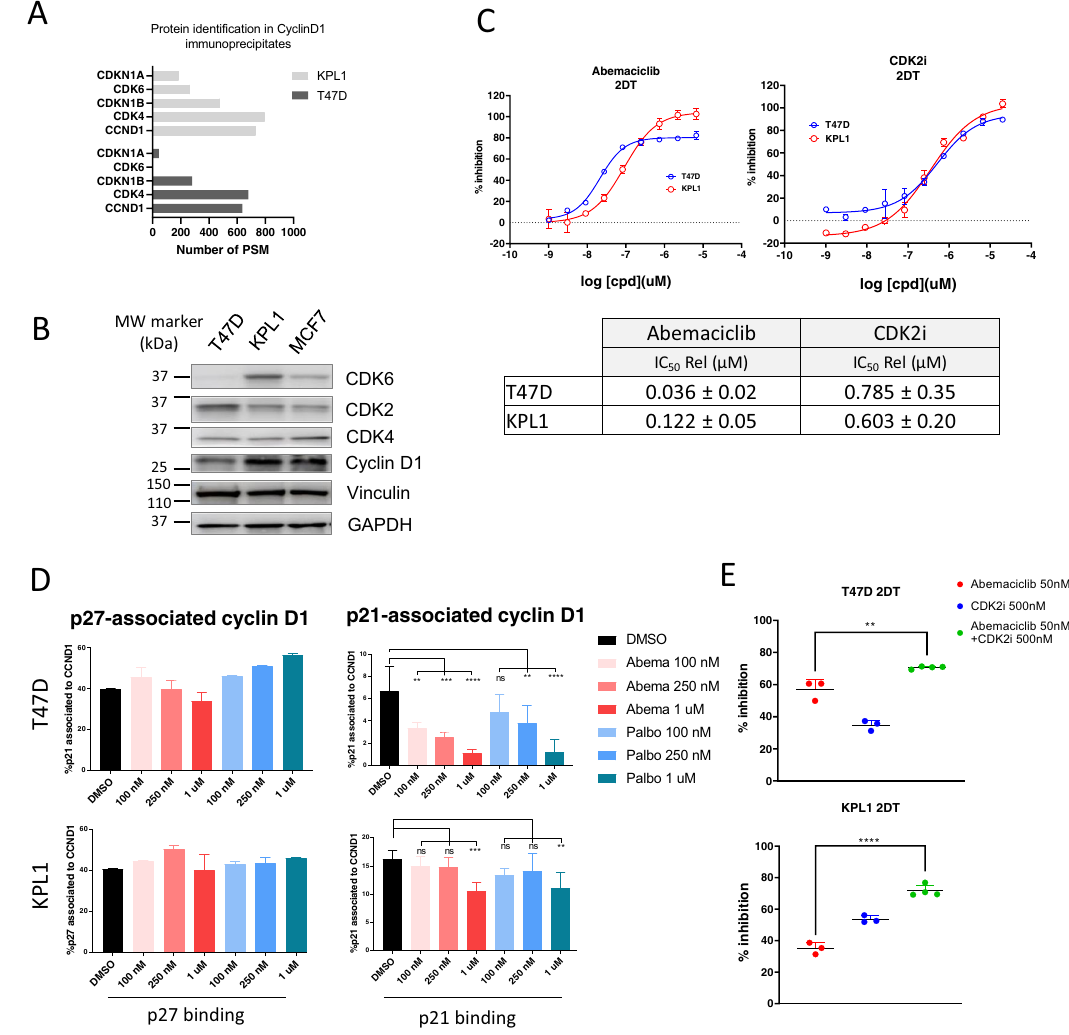
Fig. 5 p21 competition in response to CDK4/6 inhibition and combination with CDK2 inhibitor in models of high or low CDK6 expression. a Protein identi fi cation by mass spectrometry of cyclin D1-associated proteins in CDK4/6 inhibitor sensitive (T47D) and resistant (KPL1) cells. b Western blot analysis of indicated proteins and ( c ) cell proliferation following CDK4/6 inhibitor and CDK2 inhibitor (PF-07104091) treatment in T47D and KPL1 cell lines. Representative IC50 dose-response curve is shown, table summarizes average of replicates ( n = 4). d T47D and KPL1 cells were treated with vehicle or increasing concentrations of CDK4/6 inhibitors, as indicated by the x-axis, and p21 association with cyclin D1 measured. Average of two day-replicates and two technical replicates is shown. e T47D and KPL1 cells were treated for 48 h with abemaciclib or CDK2 inhibitor alone and combination and cell viability measured. ** p < 0.01, **** p < 0.0001, ns – not signi fi cant. P-values determined by pairwise t-test. Error bars represent ± standard